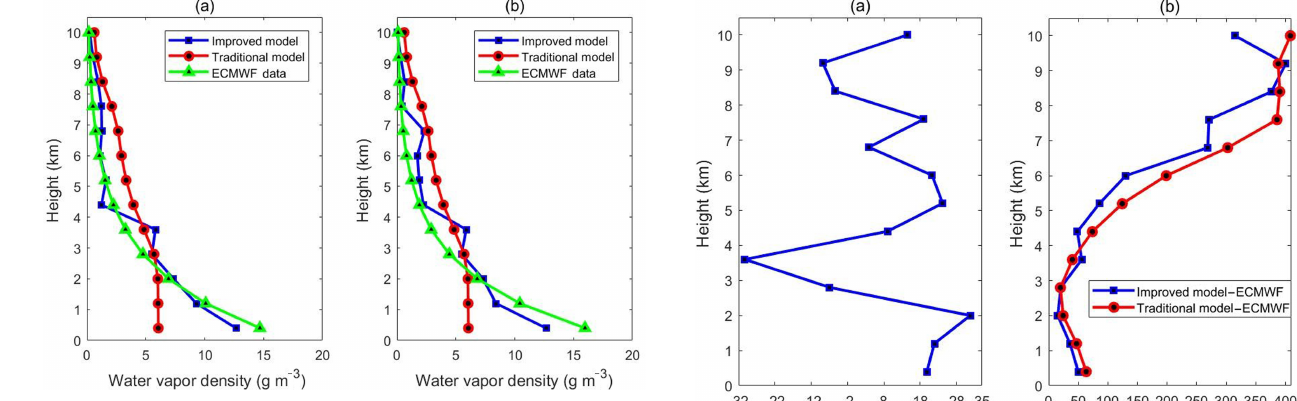
Figure 4. Water vapor profiles derived from ECMWF and two models in the scenario of voxels without penetrating GNSS rays, (a) and (b) are periods of 00:00UTC on 11 April 2014 and 12:00UTC on 11 April 2014, respectively.